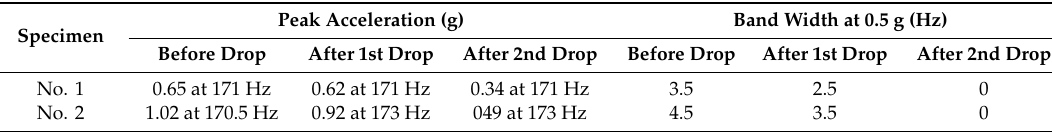
Figure 15. Comparison of the vibration acceleration of the haptic actuator before and after the drop impact tests ( a ) No. 1 specimen ( b ) No. 2 specimen. Table 4. Acceleration and frequency band variations due to the drop impact tests.